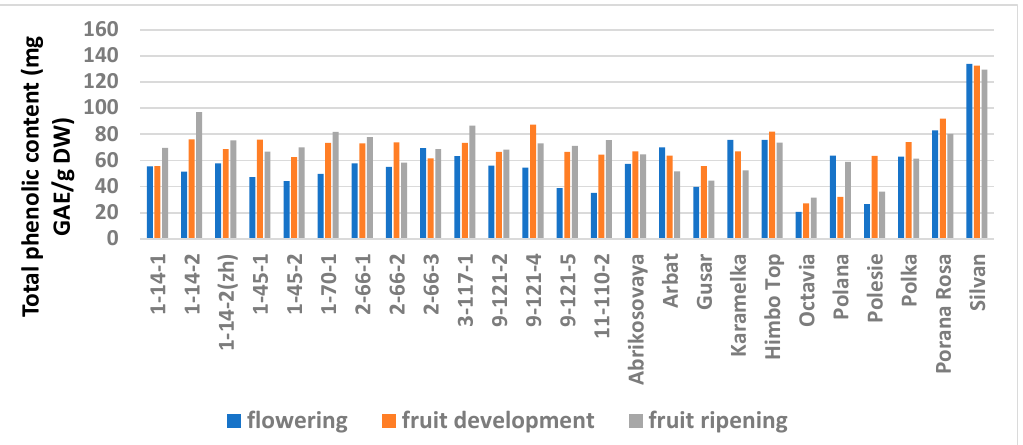
Figure 1. Effects of different harvest periods (phenophase) on total phenolic content in raspberry leaves. Statistical analysis of the data is presented in Table S6.